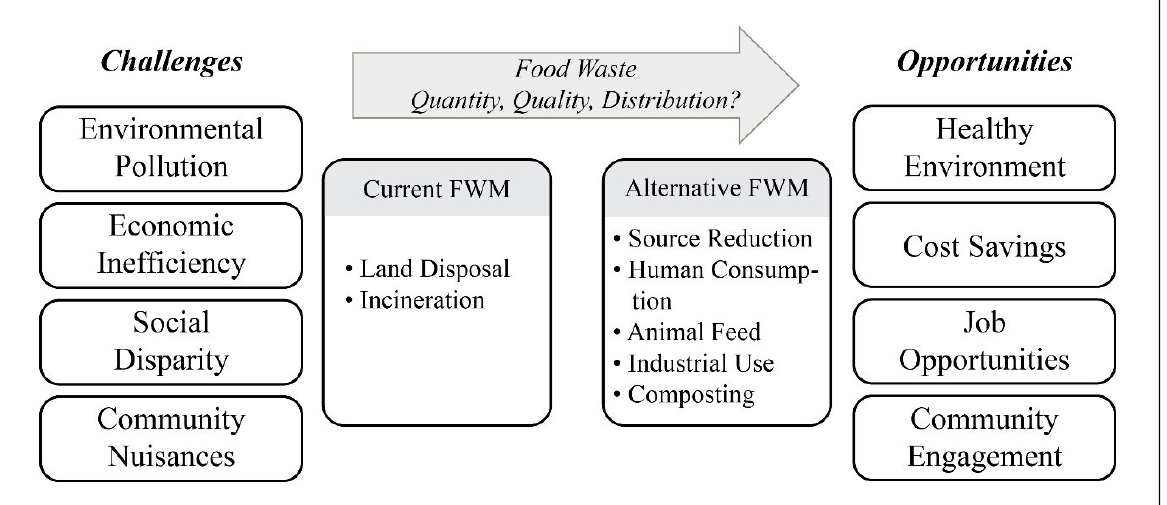
Figure 1. Challenges and Opportunities of Food Waste Management